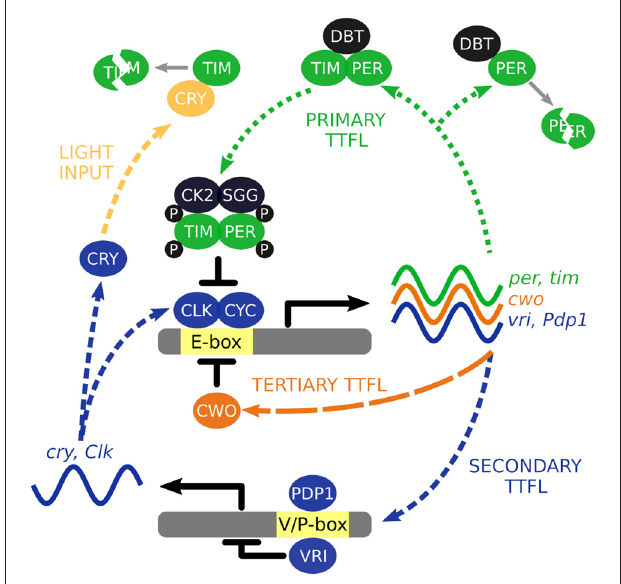
FIGURE 1 | The interlocked core transcription/translation feedback loops (TTFL) of Drosophila melanogaster . The primary TTFL is initiated by the CLK-CYC mediated transcription of the per and tim genes. The PER protein is inherently unstable and DBT will direct it for degradation unless PER is stabilized by TIM. PER and TIM are phosphorylated (P) by CK2 and SGG to negatively regulate their own expression by repressing CLK-CYC activity. VRI and PDP1 are also produced by CLK-CYC activity, each of which have potentially opposing effects and offset timing to modulate Clk and cry transcription. Light activation of CRY leads to the degradation of TIM acting as a molecular reset of the TTFL cycling. CWO is a part of third TTFL that also acts as a repressor of CLK-CYC